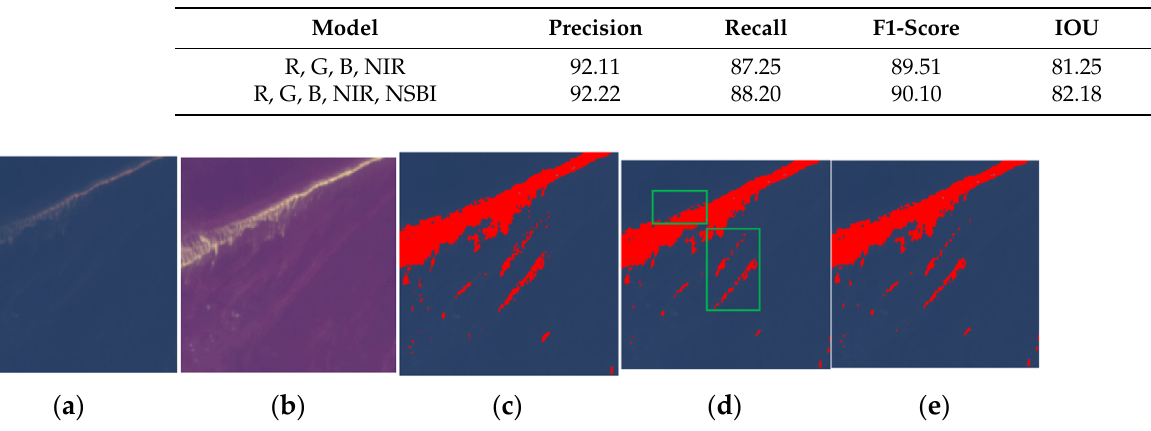
Table 5. Impact of NSBI on the performance of NSBRNet.